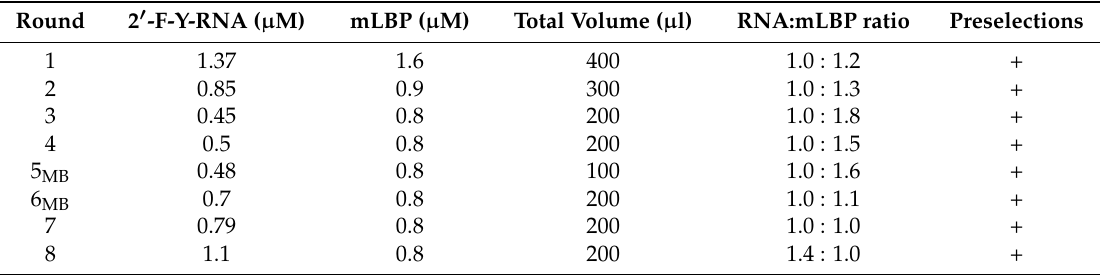
Table 1. Selection parameters and elution results of individual selection rounds. The concentration of the 2 (cid:48) -F-Y-RNA pool (2nd column) is that before preselection. The selection was performed with Ni-NTA agarose in rounds 1-4, 7 and 8, and with Ni-NTA agarose magnetic beads in rounds 5 and